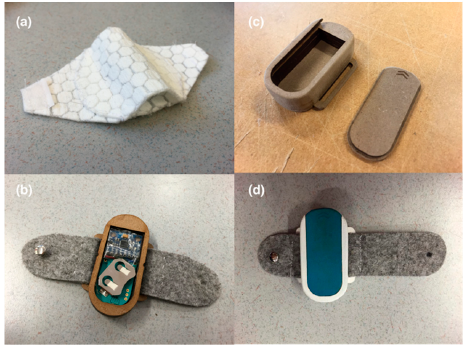
Figure 3. Successive iterations in product design: ( a ) initial fabric sensor holder; ( b ) laser-cut wooden casing of sensors with felt bands; ( c ) the construction design of the case which can be opened by sliding the lid; ( d ) final prototype wooden casing with adjusted lengths of felt